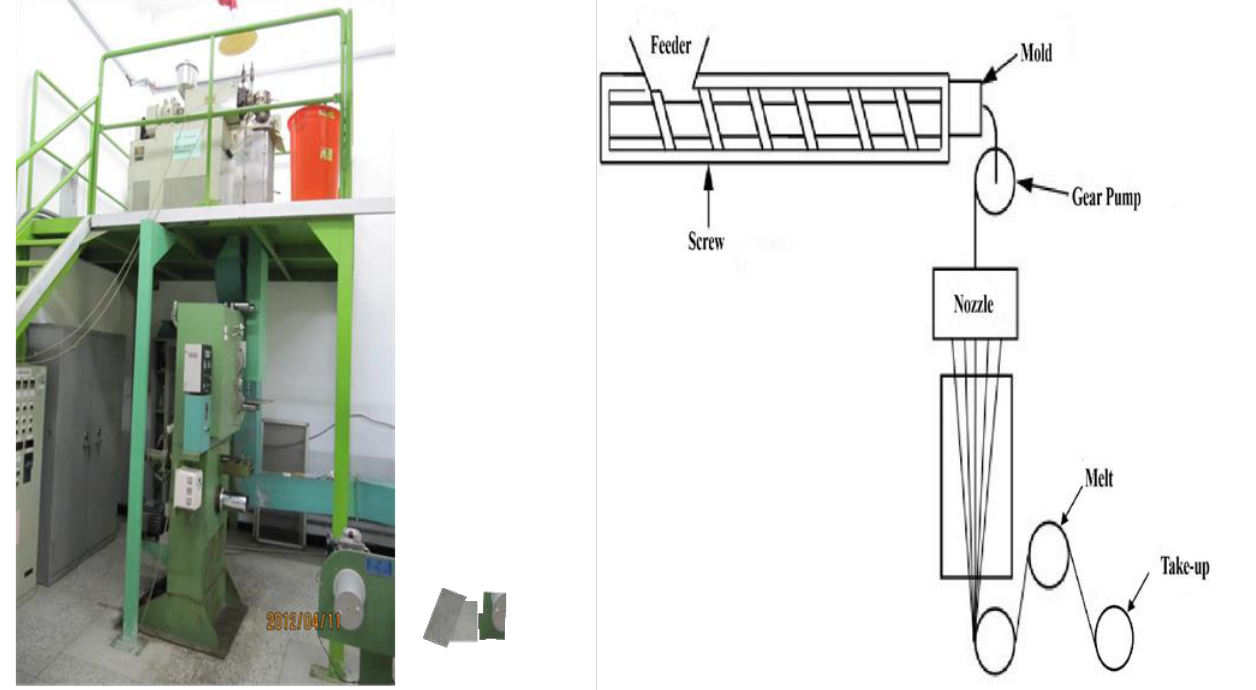
Figure 4. Melt spinning machine